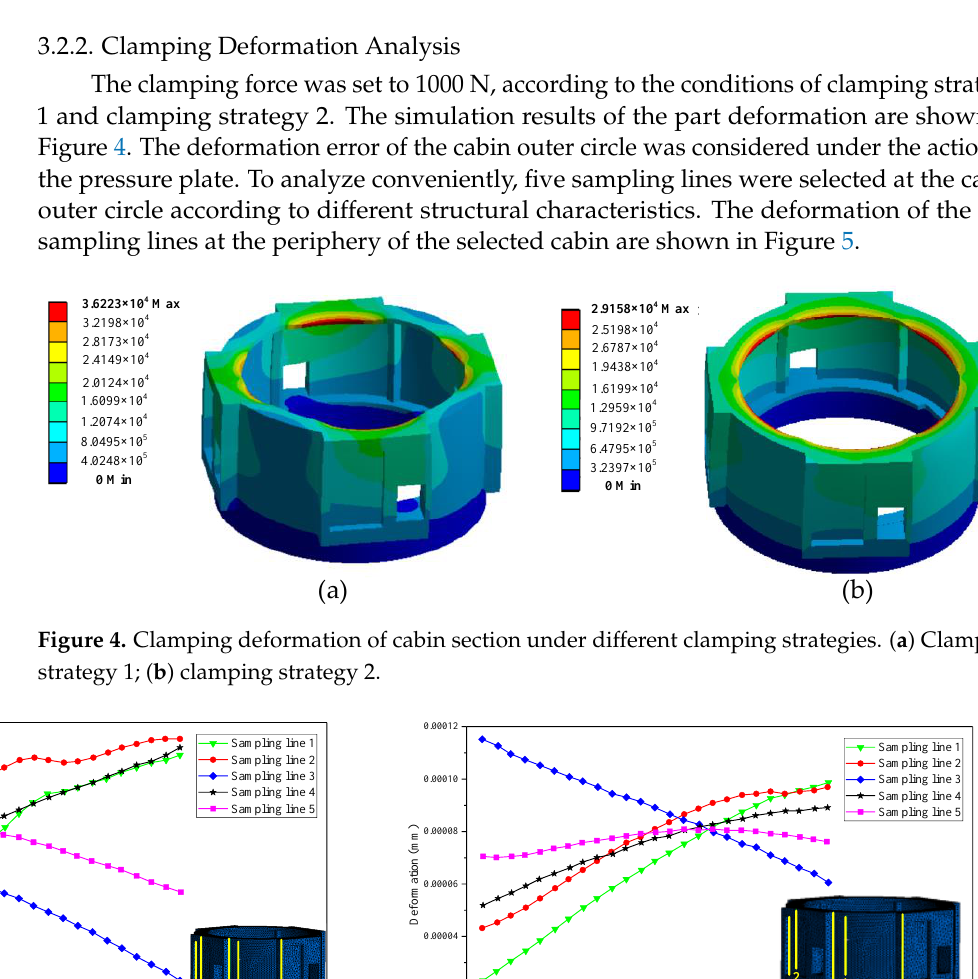
Figure 6. Deformation of inner circumference sampling line. The selection of cabin clamping strategy was completed by the above deformation simulation analysis. Clamping strategy 2 was adopted to control the clamping force. A gradually increasing clamping force was applied to cabin. Then, the trend of the maxi- mum deformation of the cabin was monitored, as shown in Figure 7. The amount of deformation increased with the increase in clamping force. When the clamping force increased to a certain value, the amount of deformation was close to the maximum allowable error. Therefore, the maximum allowable clamping force was se- lected by setting the maximum threshold of clamping deformation. Based on the above mechanical analysis method, the optimal clamping position and clamping force were determined through finite element simulation. This method changes the traditional manner of clamping parts by experience. The special tooling for parts pro- cessing was designed on the basis of the analysis results and applied in actual processing.